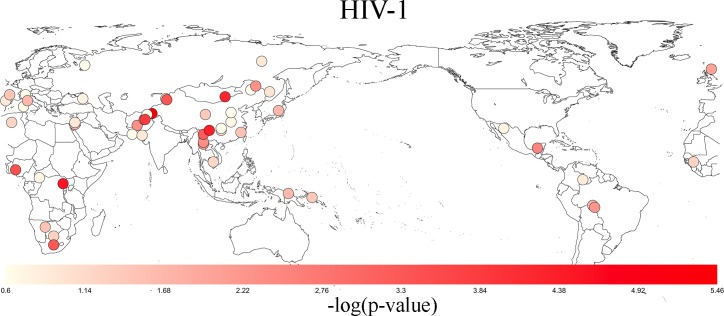
Worldwide levels of HIV-1 selection.A p-value for selection in human genes that interact with HIV-1 was produced for each population and is represented by a colored circle on the map. Significance is portrayed by a white to red gradient with lighter colors representing higher p-values and brighter red colors representing lower p-values. Only SNPs (filtered for LD) within genes that interact with Y. Pestis were included in determining the p-values. The most significant p-values were found in East Asia and Africa.